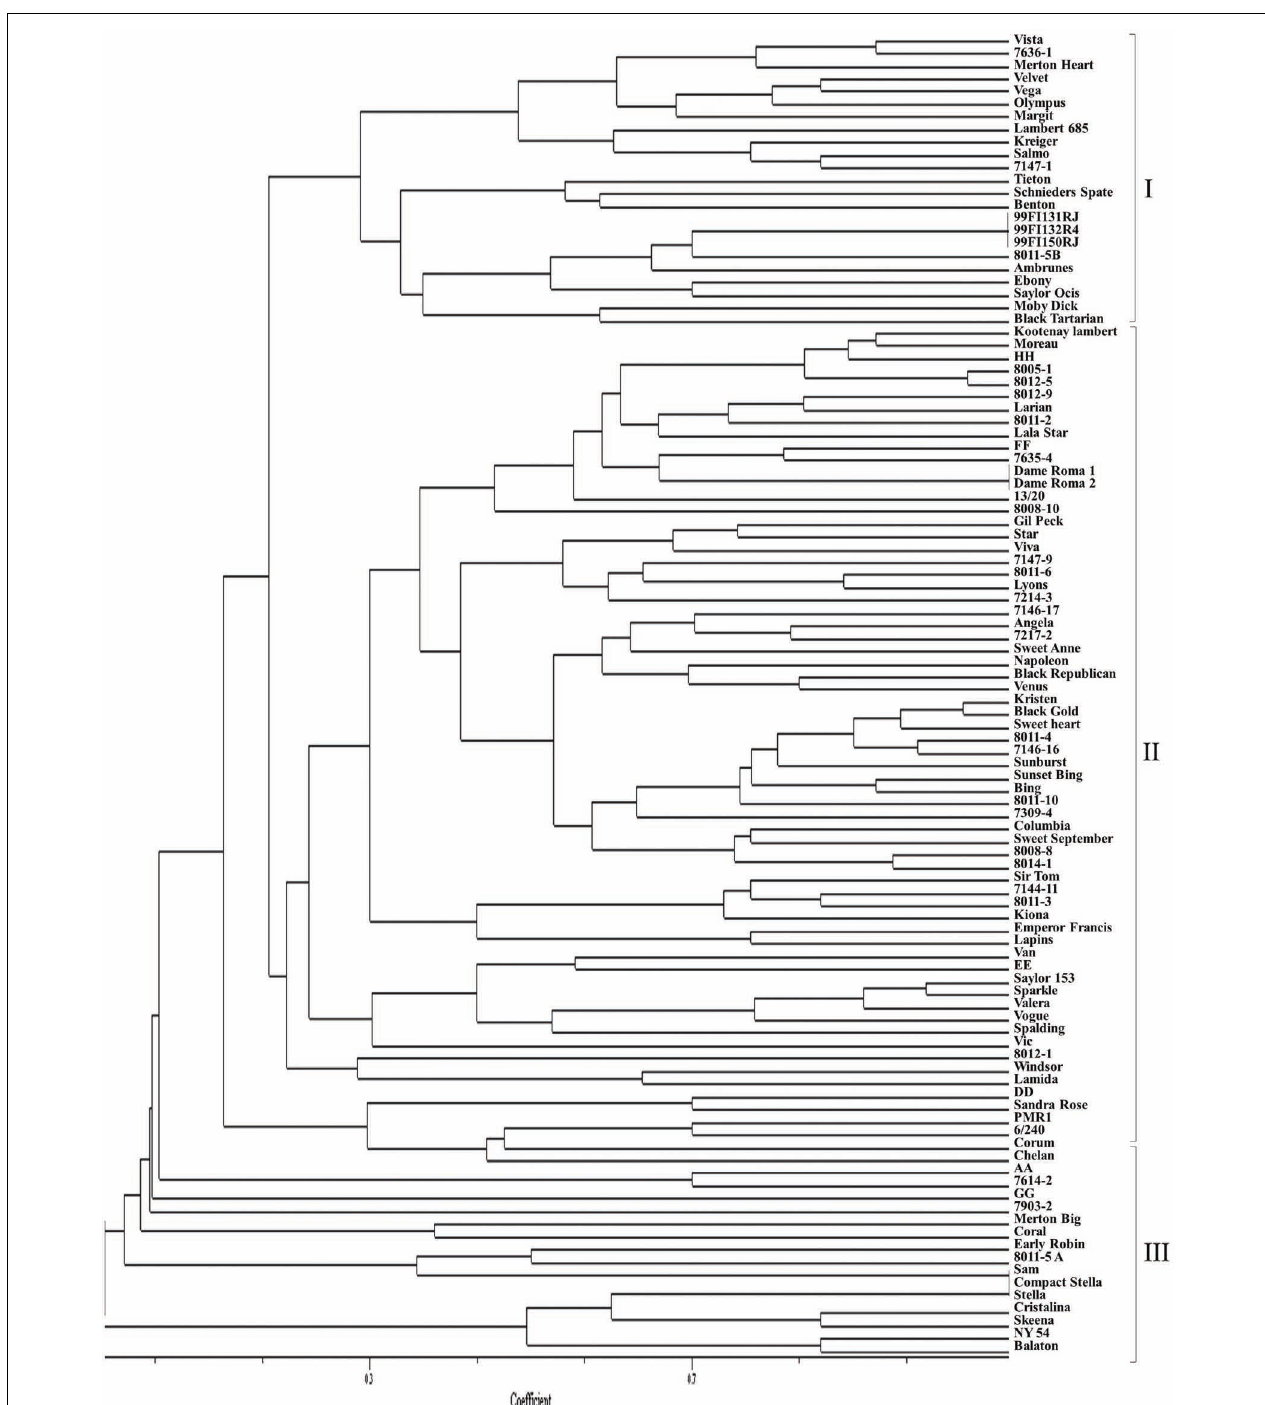
FIGURE 2 |A dendrogram based on SSR data depicting the relationships of the sweet cherry